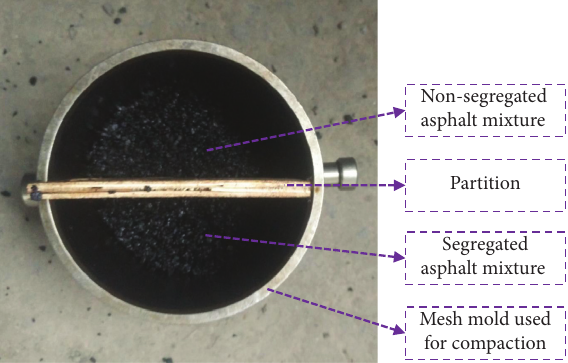
Figure 6: Mesh mold used for compaction. Table 9: Measured air voids of TGs